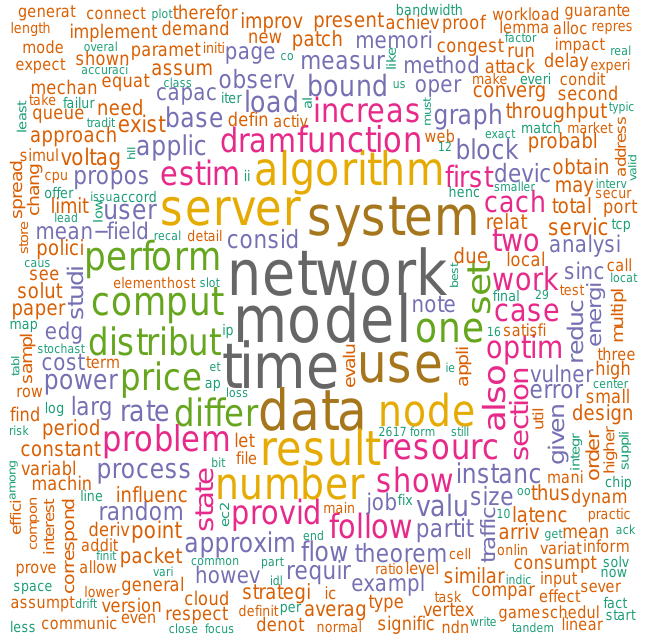
Figure 6. Word cloud of top terms by frequency.